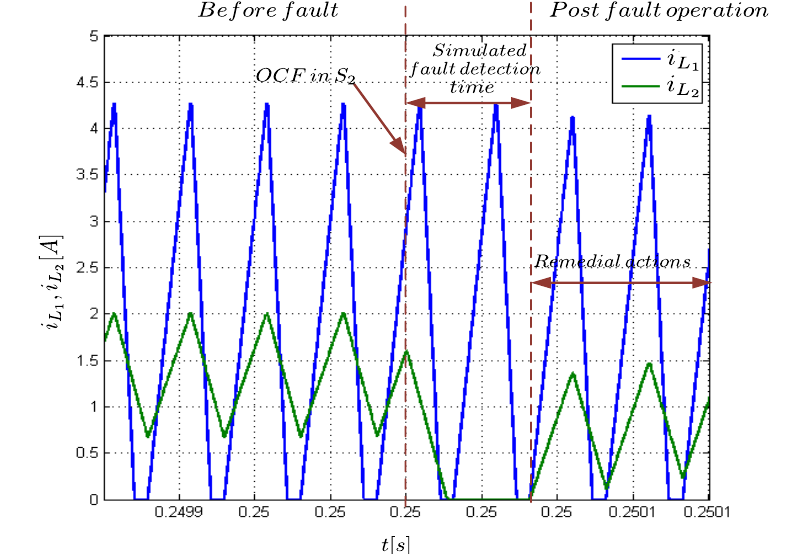
Figure 19. OCF in S 2 at t = 0.25 s: currents flowing through the inductors L 1 and L 2